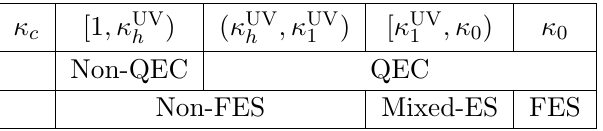
Table 4 . The property of QEC and ES for tensor networks with f b; a g tiling in the UV, f b 0 ; a g tiling in the IR.